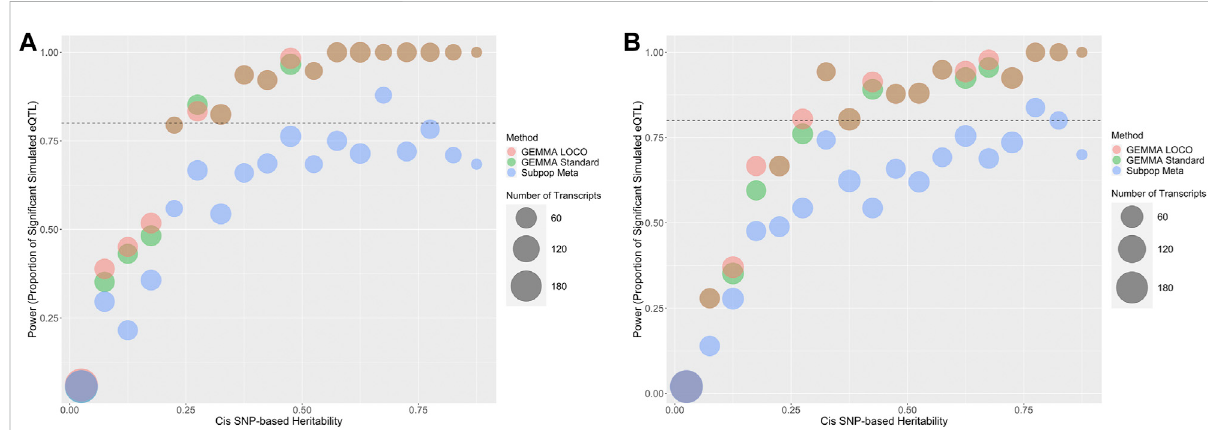
FIGURE 6 Predicted power in cis-eQTL studies based on cis-heritability of the transcript and QTL mapping method. The number of genes in each heritability strata is represented by the size of the bubble. Standard GEMMA is in green, GEMMA LOCO is in red, and subpopulation meta is in blue.